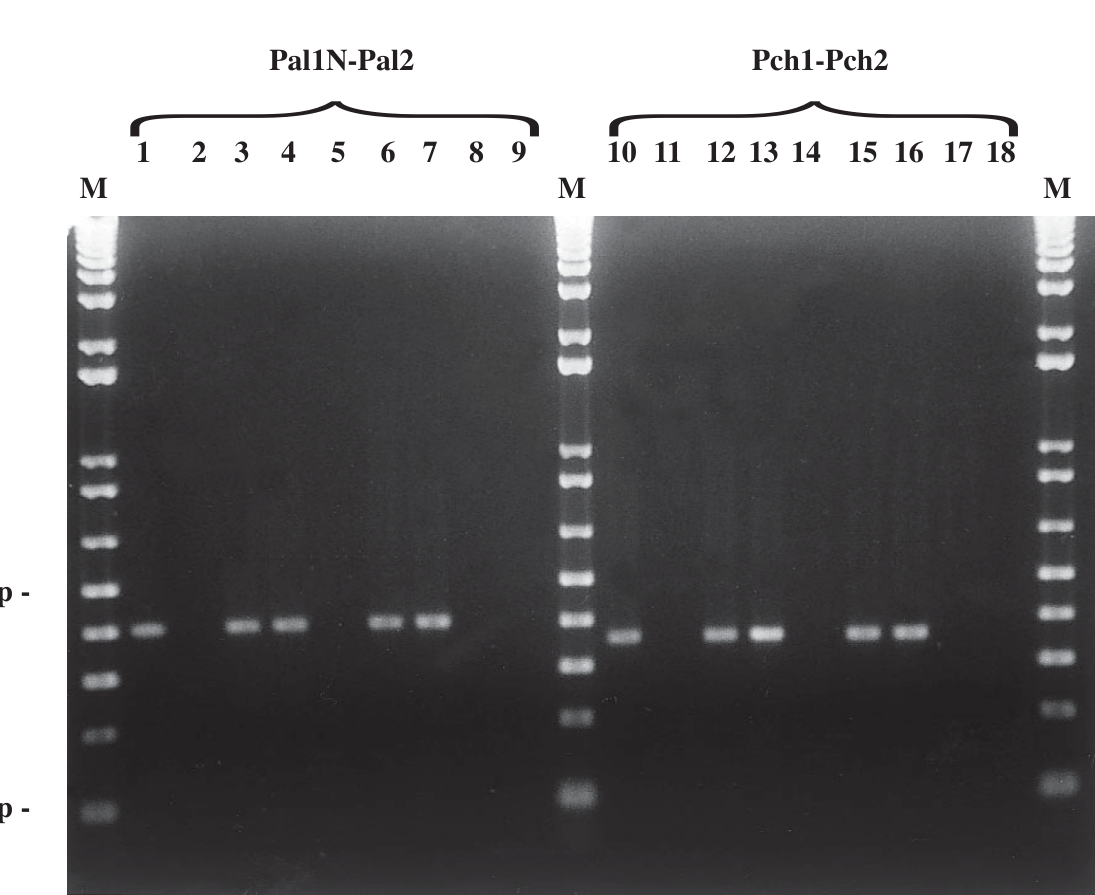
Fig. 6. Gel electrophoresis of the PCR products obtained with primer pairs Pal1N-Pal2 (lanes 1-9) and Pch1-Pch2 (lanes 10-18), using as template fungal DNA or DNA extracted from infected or contaminated grapevine wood. Lanes 1 and 11, P. aleophilum 157; lane 2 and 10, P. chlamydosporum 56 DNA; lanes 3-5, grapevine wood of plants infected with each of Pal, Pal plus Pch and Pch ; lanes 6-8, grapevine wood from healthy plants and artificially contaminated with 10 4 c.f.u. each of Pal, Pal plus Pch and Pch ; lanes 12-14, grapevine wood of plants infected with each of Pch , Pch plus Pal and Pal ; lanes 15-17, grapevine wood from healthy plants and artificially contaminated with 10 4 cfu each of Pch , Pch plus Pal and Pal ; lanes 9 and 18, negative control with sterile distilled water; lane M, 1Kb Plus DNA Ladder (Gibco-BRL, Life